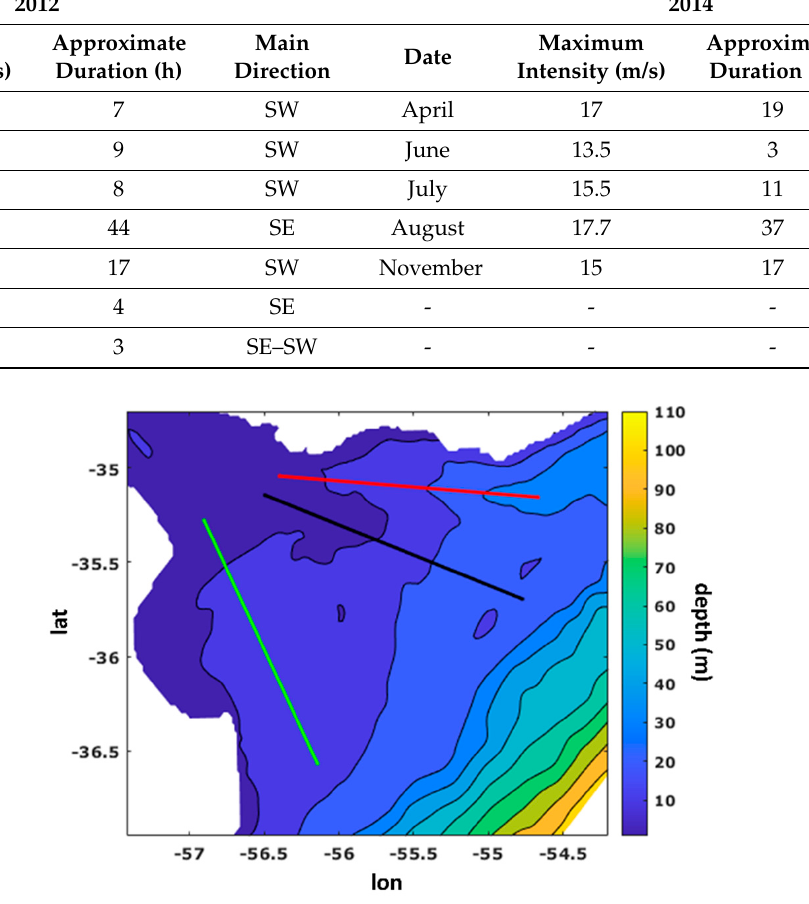
Figure 7. Location of the three longitudinal sections considered for the analysis: Section 1 for the Canal Oriental (Red), Section 2 for the Arquimedes and Inglés banks (Black), and Section 3 for the Canal Marítimo (Green). Bathymetry in m.